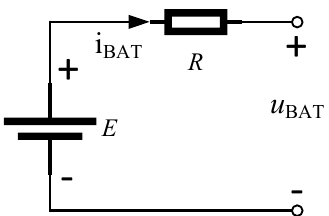
Figure 2. Equivalent circuit model of the battery.